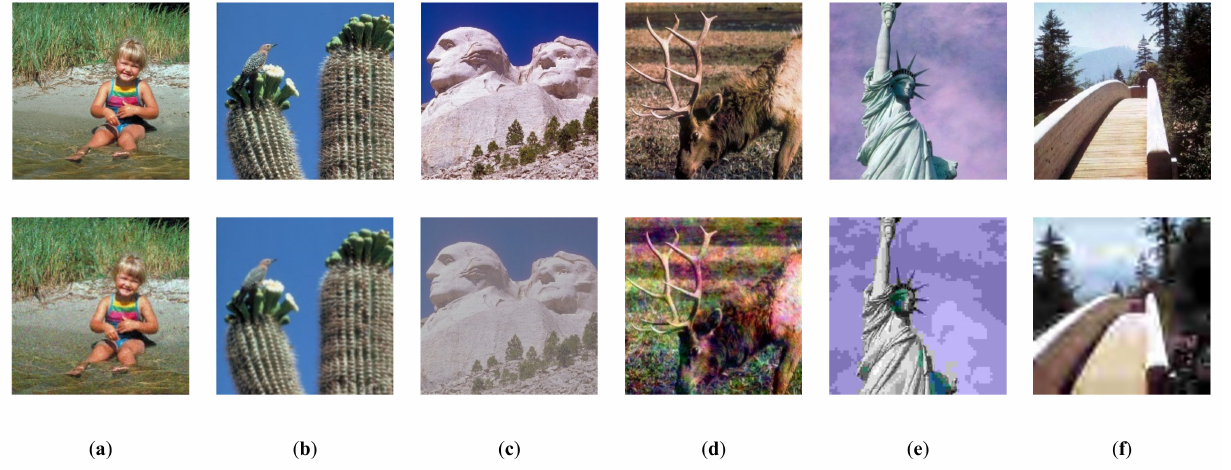
Figure 8. Distorted images in the synthetic dataset CSIQ and the corresponding reference images, corresponding to the distortion types ( a ) White Noise ( b ) Gaussian Blur ( c ) Contrast stretching ( d ) Pink noise ( e ) JPEG Compression ( f ) JPEG2000